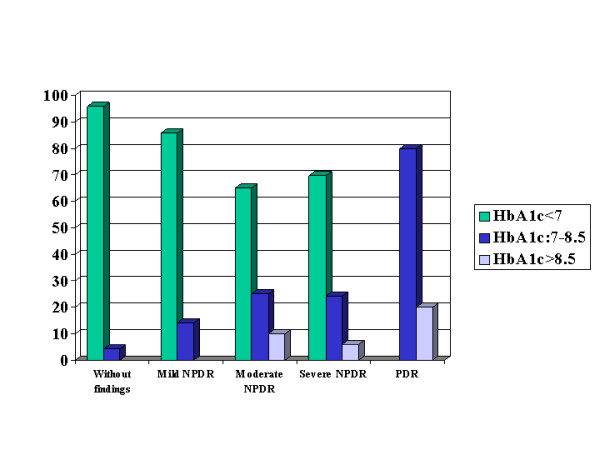
Graph presenting the positive association between the severity of DR and HbA1c levels.